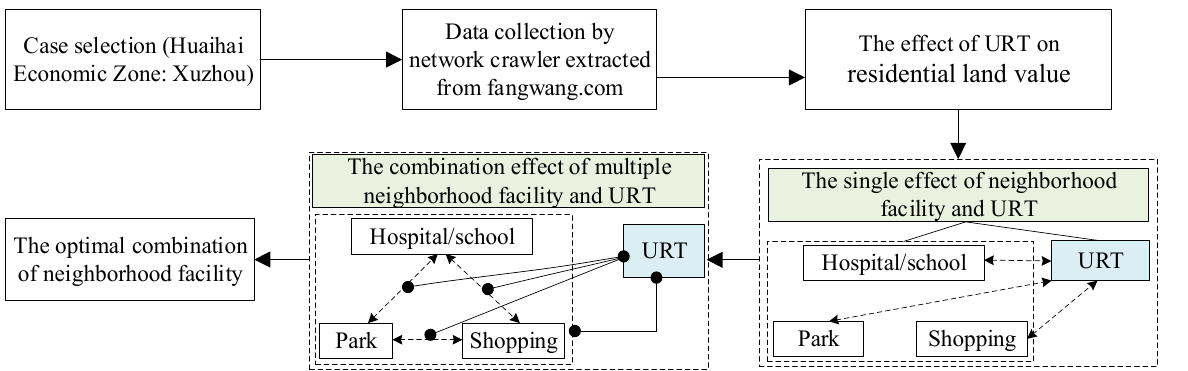
Figure 2. The research framework.